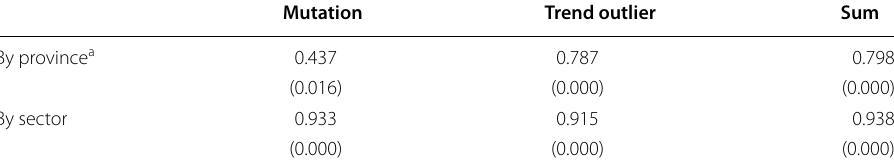
a Numbers in parenthesis are significance level Table 6 Best and worst IO data quality regarding province in each period Best data quality,